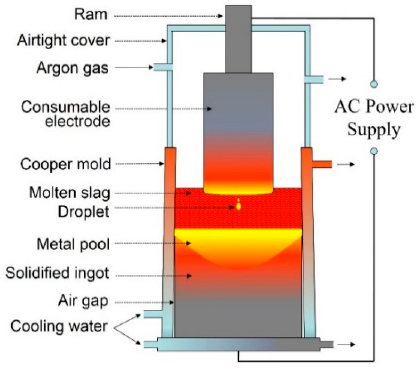
Figure 1. Schematic of electroslag remelting (ESR) process under argon protection.